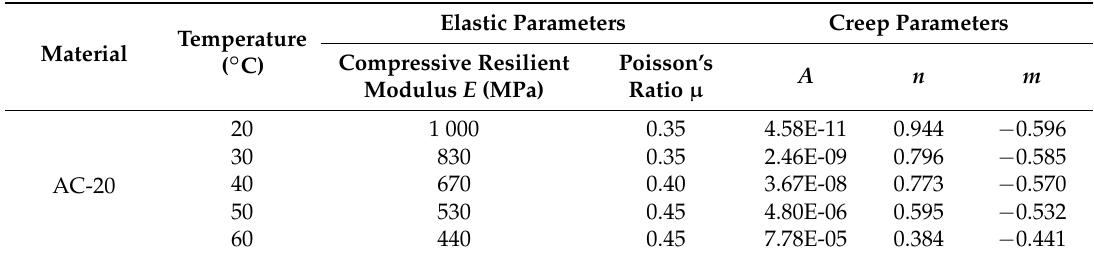
Table 14. Material parameters of middle surface layer of conventional asphalt